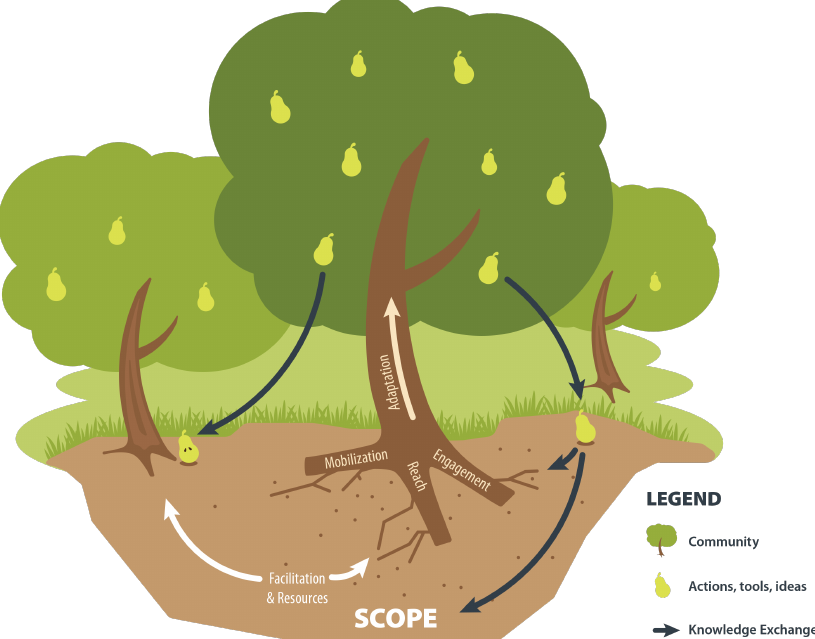
Figure 1. Implementing Live 5-2-1-0 via the RE-FRAME